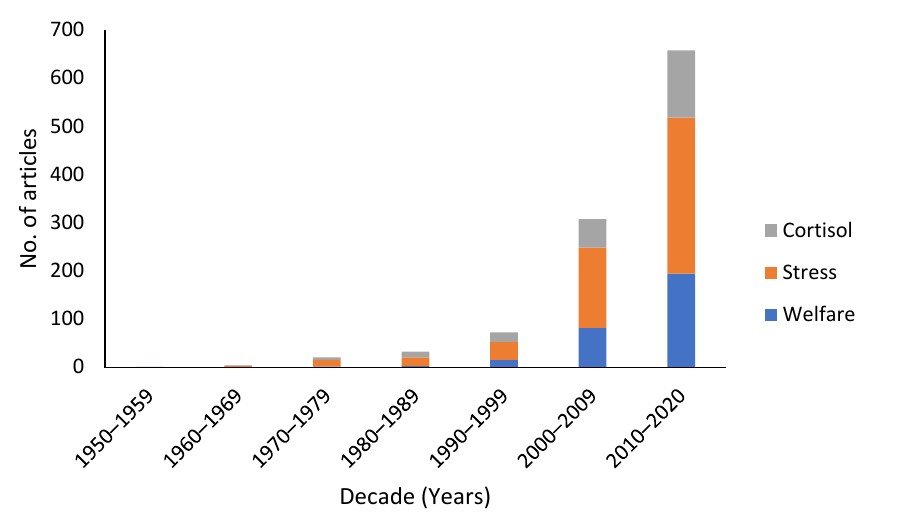
Figure 1. Number of published articles that focused on marine mammal welfare, by including the terms welfare, stress or cortisol, in the title, abstract or keywords between 1950 and 2020.